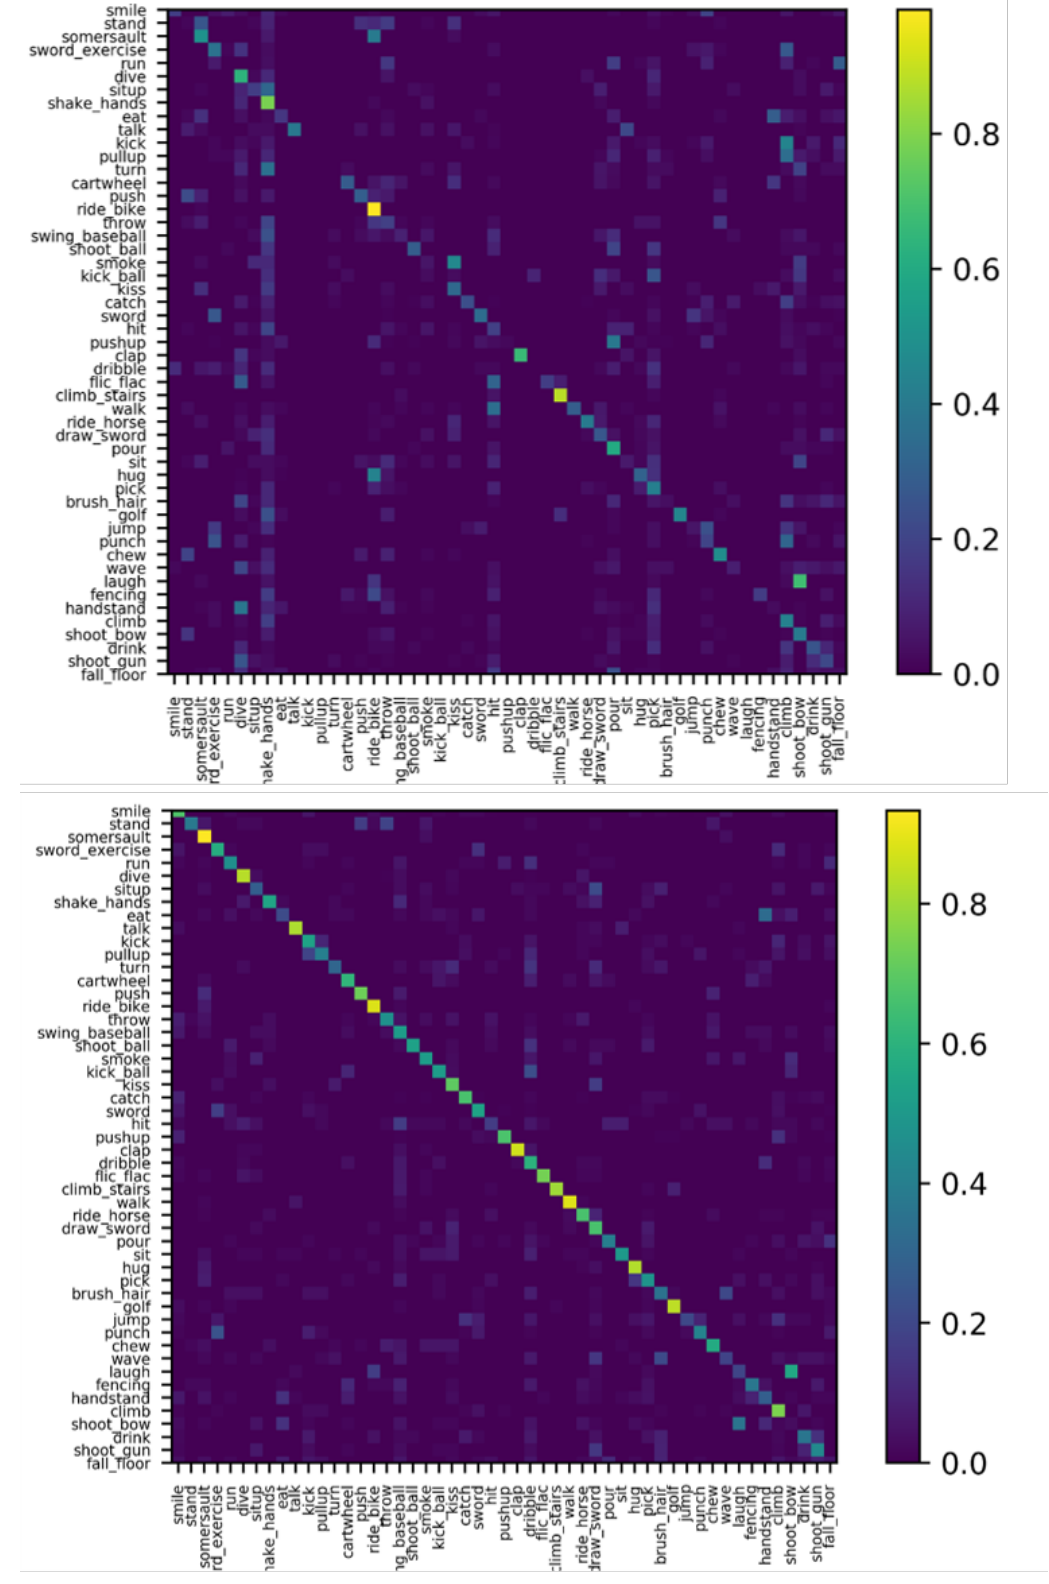
Figure 8. Confusion matrix on the 12 × 16 HMDB51 dataset. The X-axis denotes the predicted labels, and the y-axis presents the ground truth labels. ( a ) The result of our baseline model without the super-resolution module and long-range temporal convolutions. ( b ) The result of our proposed model with a super-resolution module and long-range temporal